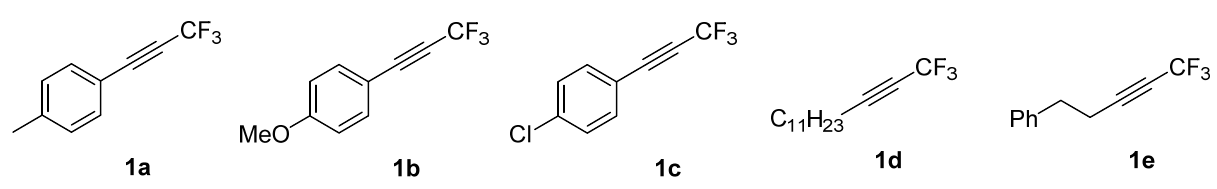
Figure 1. Dissymmetric fluorinated alkynes used in this study.